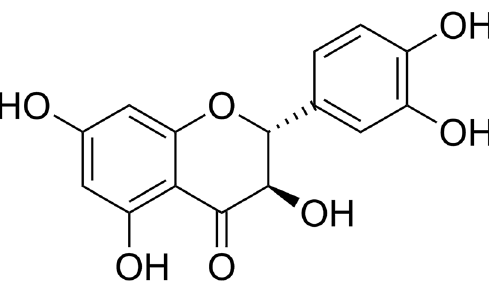
Figure 1. Tyrosinase inhibitor, Taxifolin (5,7,3 ′ ,4 ′ -flavan-on-ol), also known as